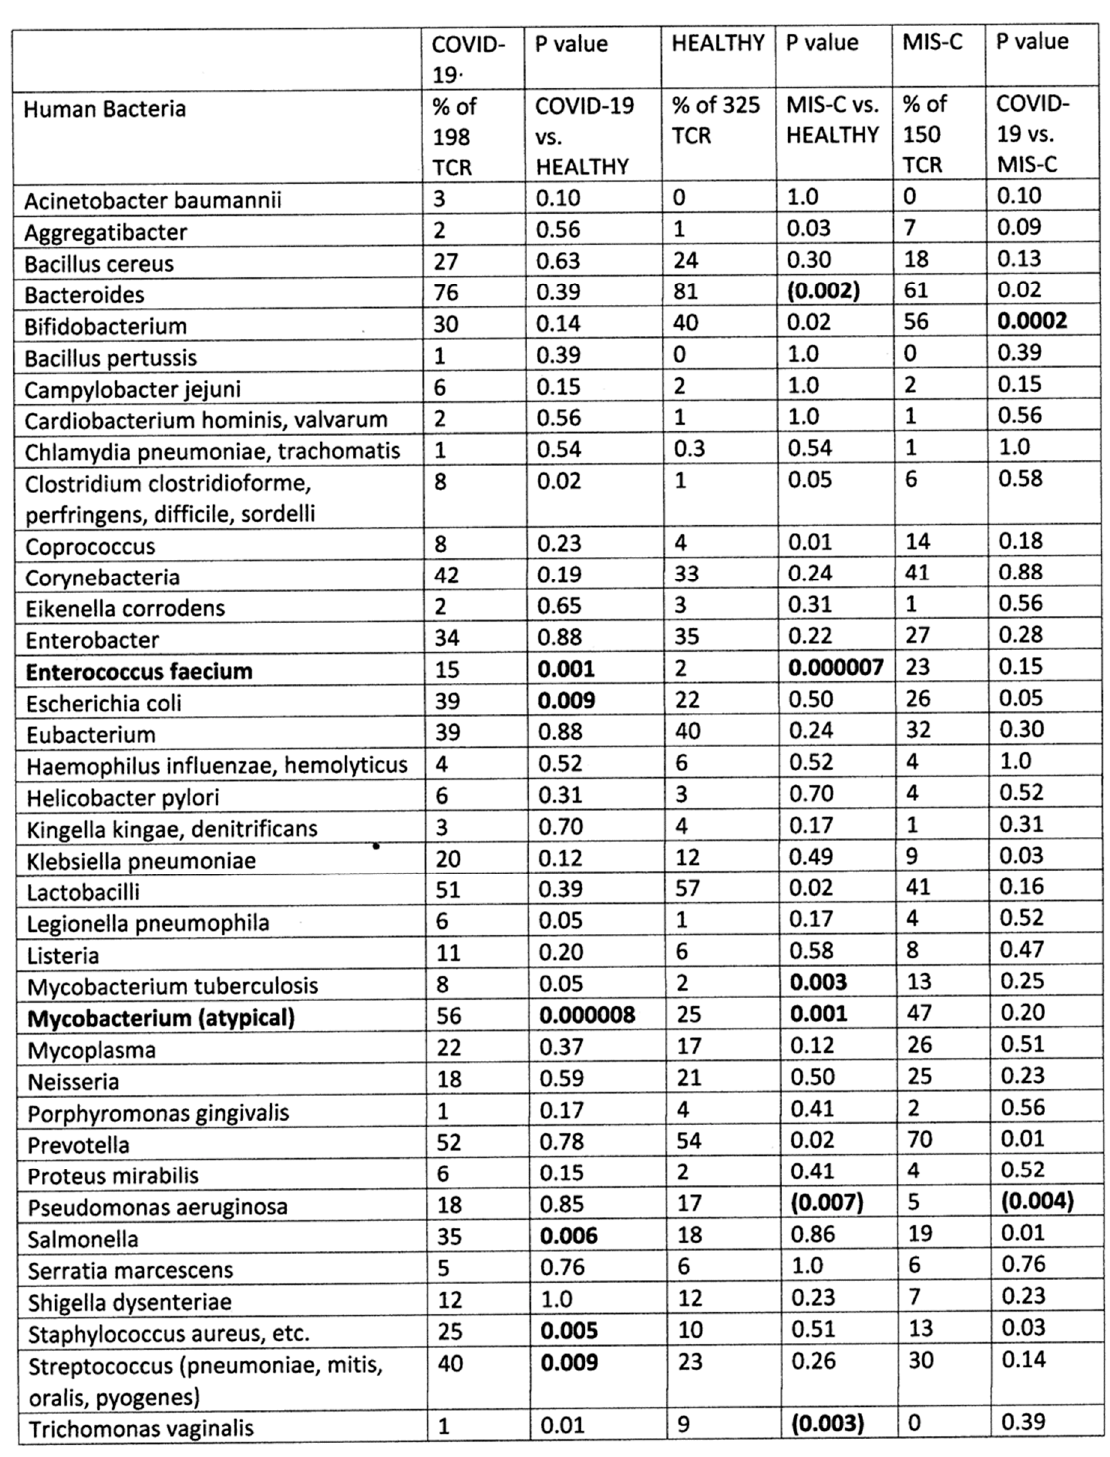
Figure 2. Summary of frequency (by percentage of TCRs tested) of TCR sequence similarities for hospitalized COVID-19 patients, healthy individuals, and multisystem inflammatory syndrome in children (MIS-C) patients to proteins from human bacteria. The statistical significance of differences between each pairing was determined by chi-squared analysis providing a p value. However, because each TCR was analyzed against every virus, a Bonferroni correction was required to interpret the resulting p values such that to reach a significance of p < 0.05 after the correction, the chi-squared value must be 0.002 or less. Values less than 0.002 or approaching it are bolded in the figure for ease of recognition. p values in parentheses indicate that there is a significant decrease in prevalence of matches compared with the healthy